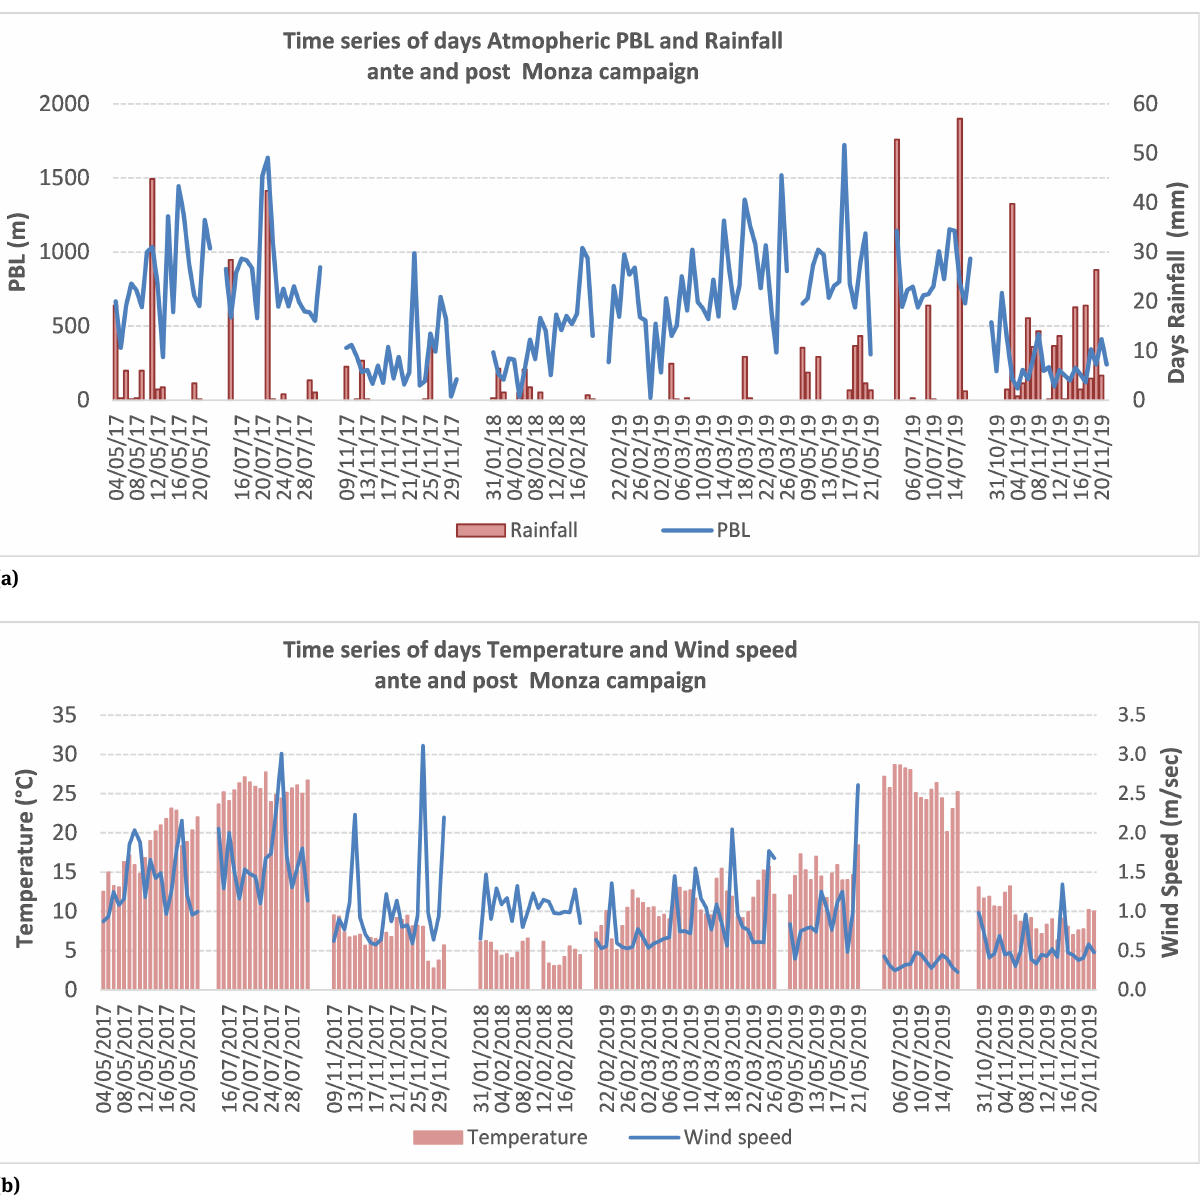
Figure 10: Monza: ex-ante and post measuring campaign; Daily Temporal pattern for some atmospheric parameters